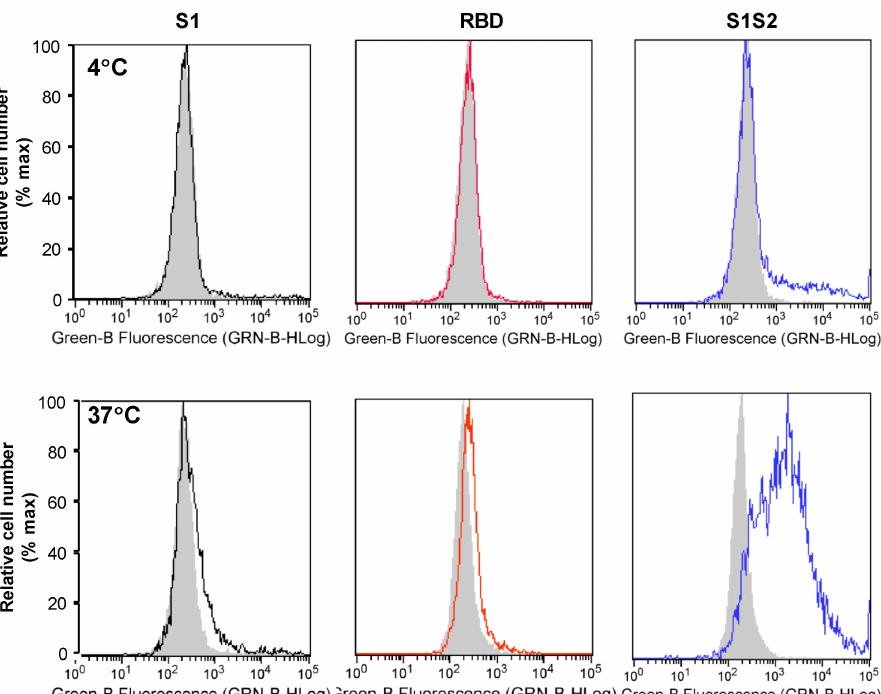
Figure 2. S1S2 interaction with human cells is temperature dependent. Attachment of S1, RBD and wtS1S2 (black, red and blue lines, respectively) compared to secondary-only control (solid grey), at 4 ◦ C (Top panels) or 37 ◦ C (Lower panels). RT4 cells were incubated with 330 nM S1-Fc, 10 µ M RBD or 330 nM S1S2-His6 protein for 60 min at either 4 or 37 ◦ C, before staining with anti-mouse Ig labelled with FITC or anti-His6 secondary antibody labelled with Dylight 488 for 30 min at 21 ◦ C. Cell-associated fluorescence was measured by flow cytometry. Results are representative of at least 3 separate